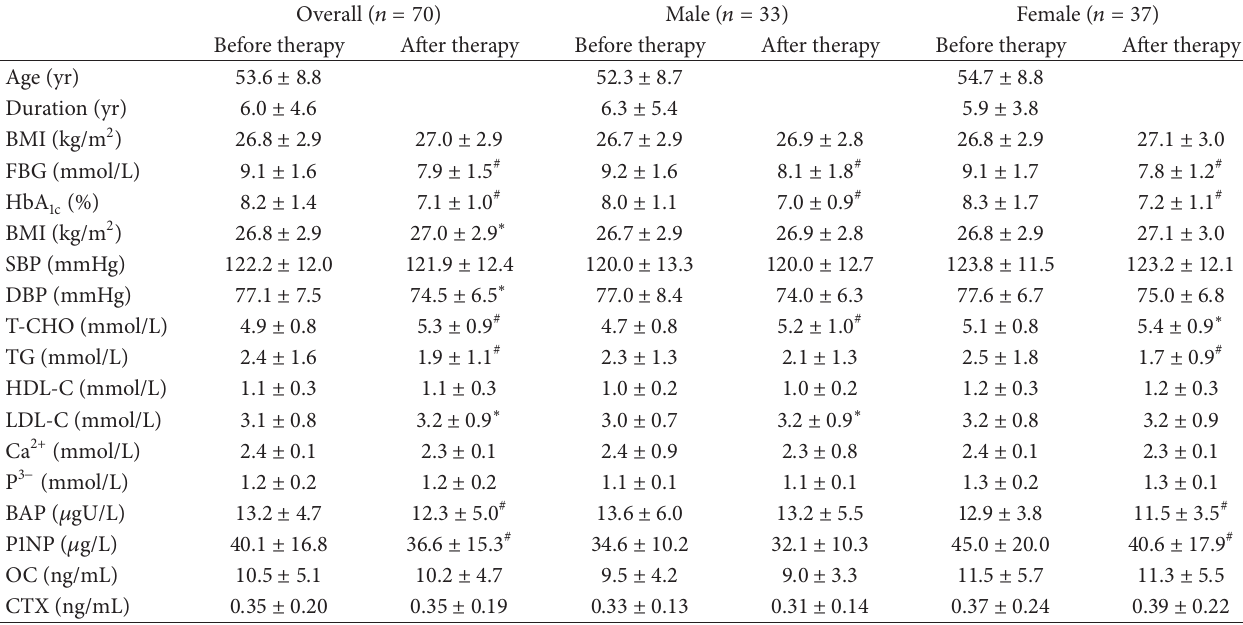
Table 1: Changes of metabolic profiles and bone turnover markers after pioglitazone treatment. Overall ( 𝑛 = 70 ) Before therapy